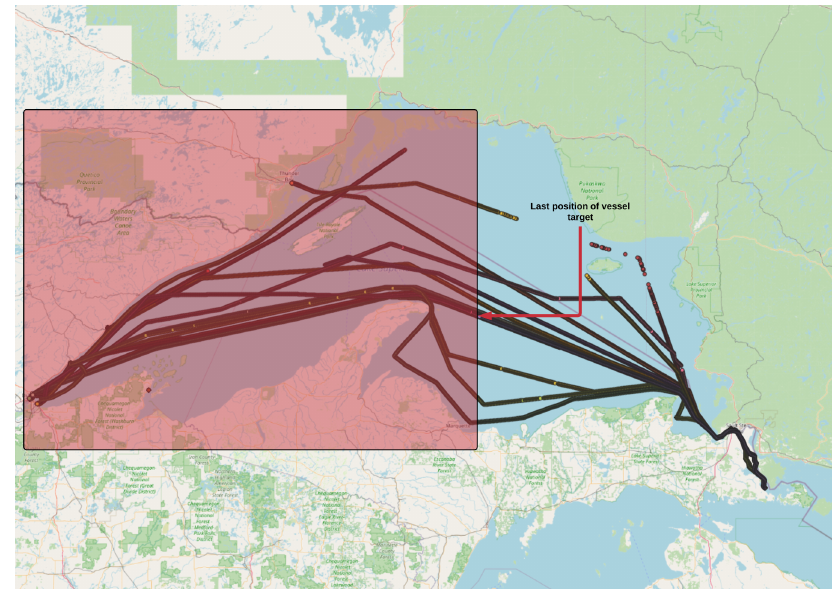
Figure 5. The data in the red section are